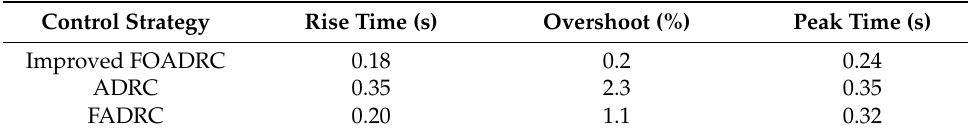
Figure 13. Sine signal response curve. Table 5. Comparison of di ff erent control performance indicators.